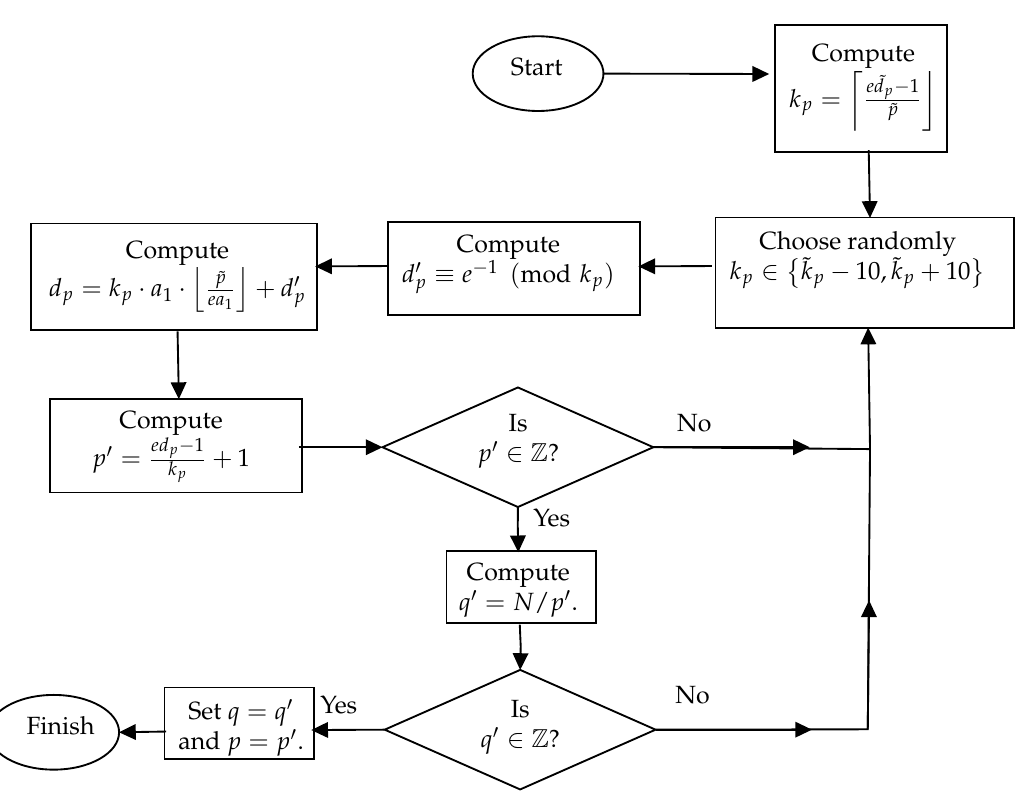
Figure 1. Flowchart of Algorithm